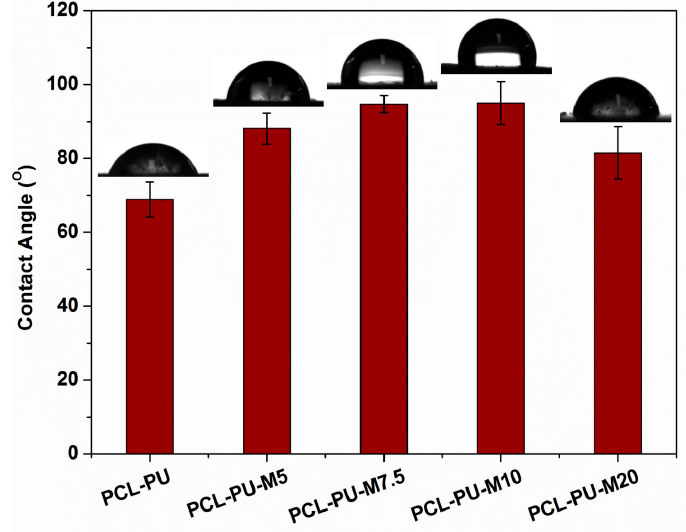
Figure 3. ( a ) X-ray diffraction of the PCL-PU and PCL-PU-Chitosan biocomposite and ( b ) X-ray diffraction comparison of the stretched and non-stretched biocomposite sample.